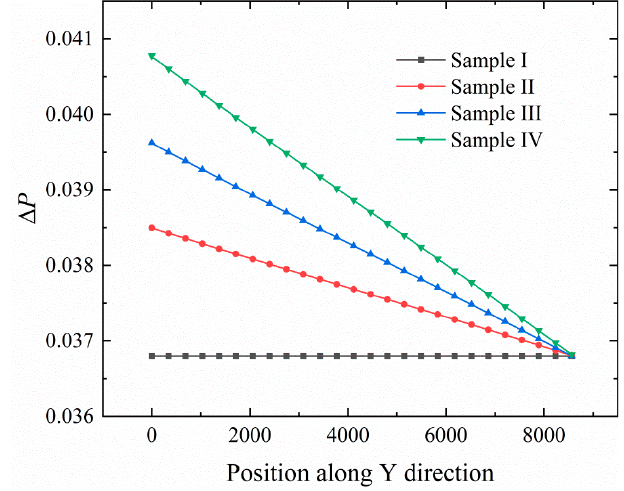
Figure 8. Distribution of Δ P in equilibrated sample I–IV along the direction of supergravity (the Y direction). Gradient distribution of the pressure in undercooled liquid can be clearly observed, and the supergravity field strength is arranged in the order of sample IV > sample III > sample II > sample I.